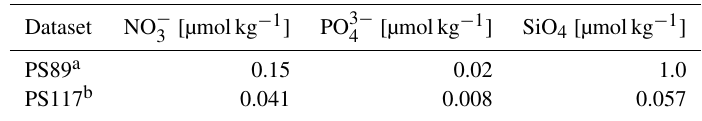
Table C3. Analytical precisions for nutrient